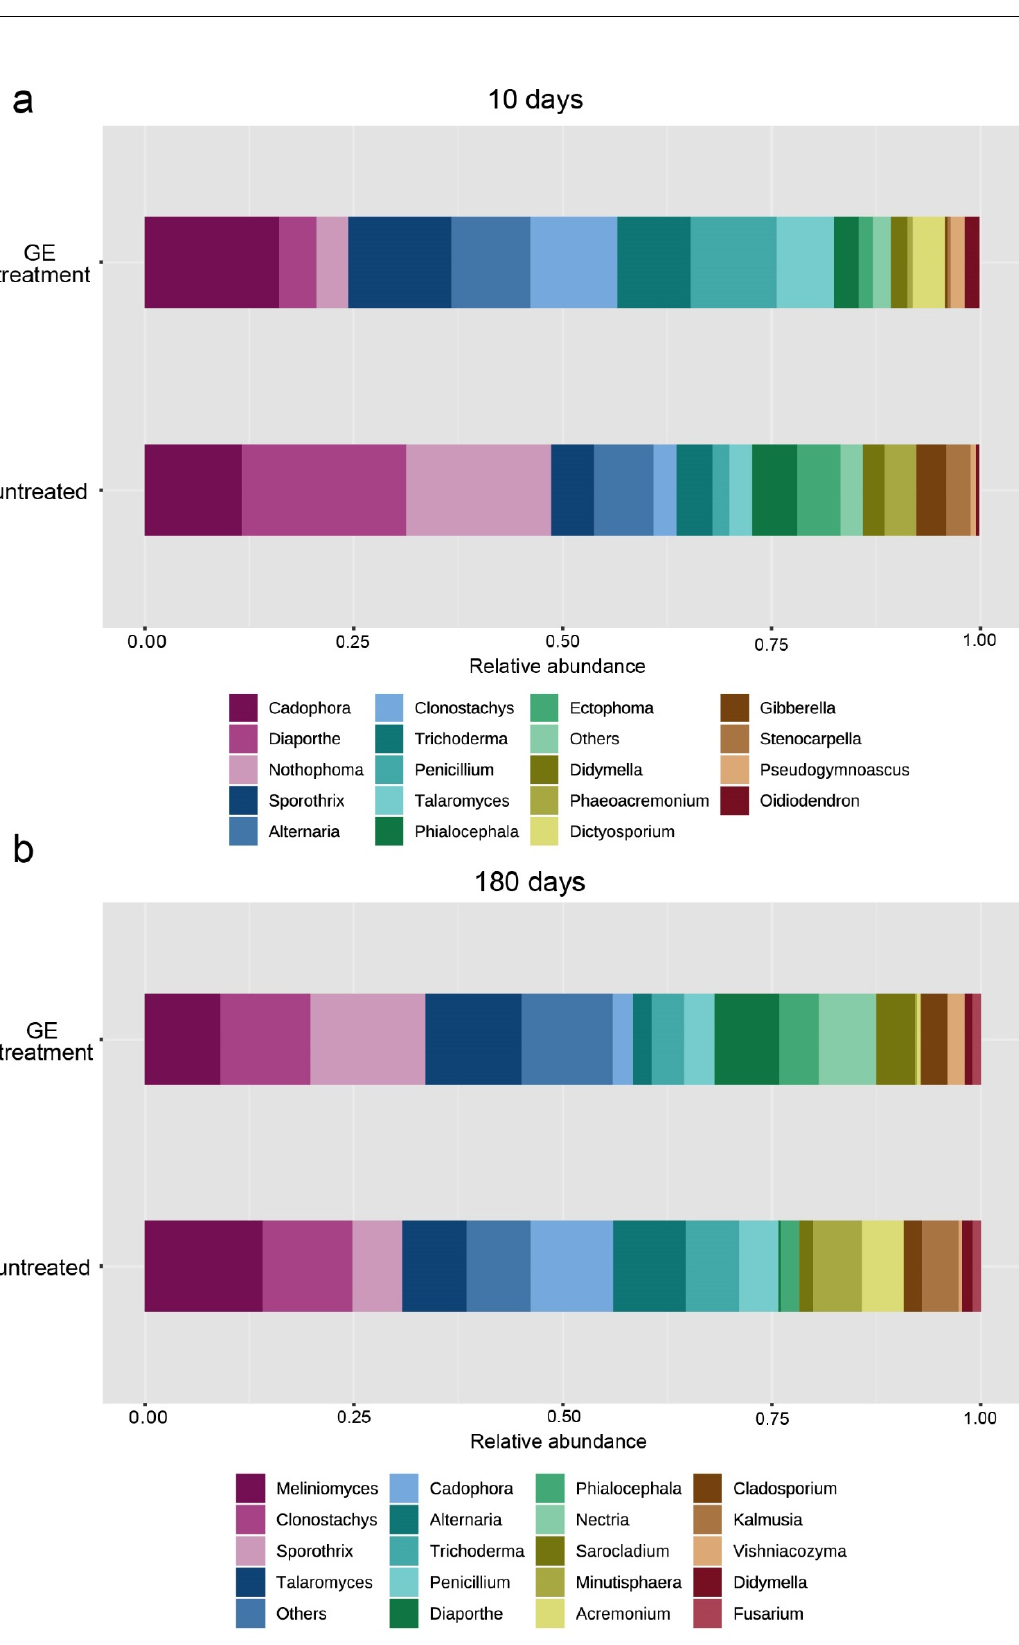
Figure 4. Relative abundances of the different fungal genera in plants treated by GE × untreated plants in two terms after sampling: ( a ) 10 days after treatment; ( b ) 180 days after treatment.